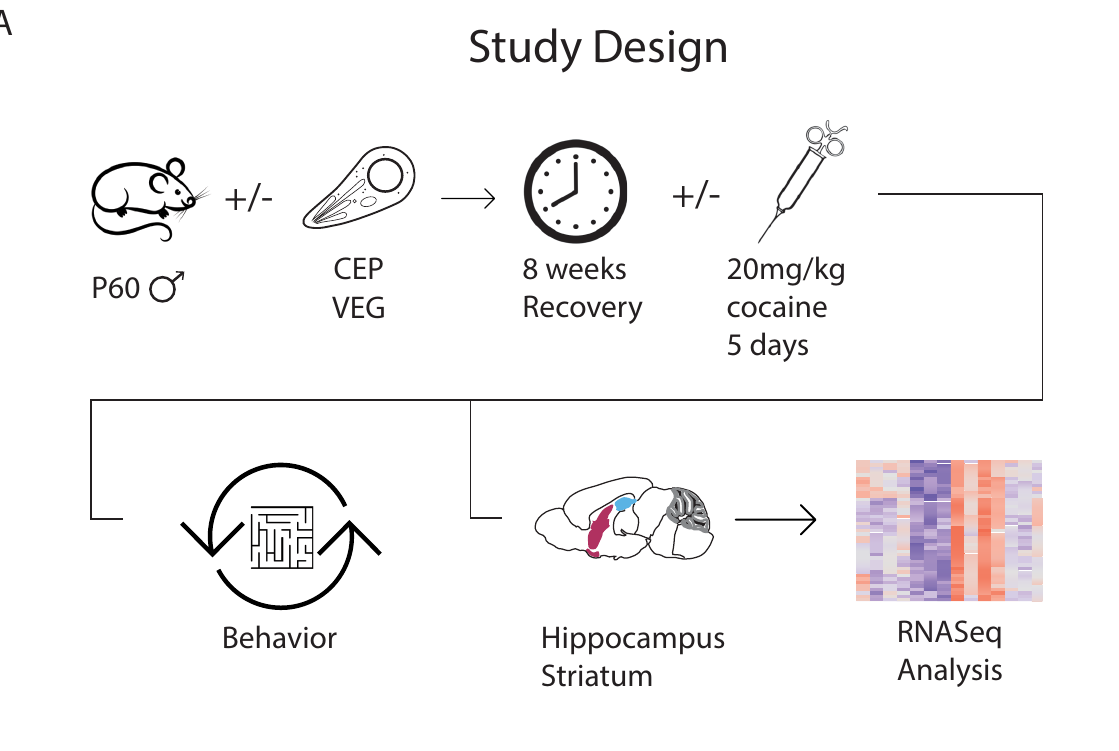
Fig 1. Study design and histological images of T . gondii infection in the mouse brain. A. Schematic overview of study design. B-C. Images showing sections of mouse brain exhibiting wide-spread infection of GFP-expressing T . gondii (strain CEP; green Propidium iodide counterstain; blue; larger cysts and smaller inclusions can be seen throughout the brain including in the cerebellum (B) and striatum (C).